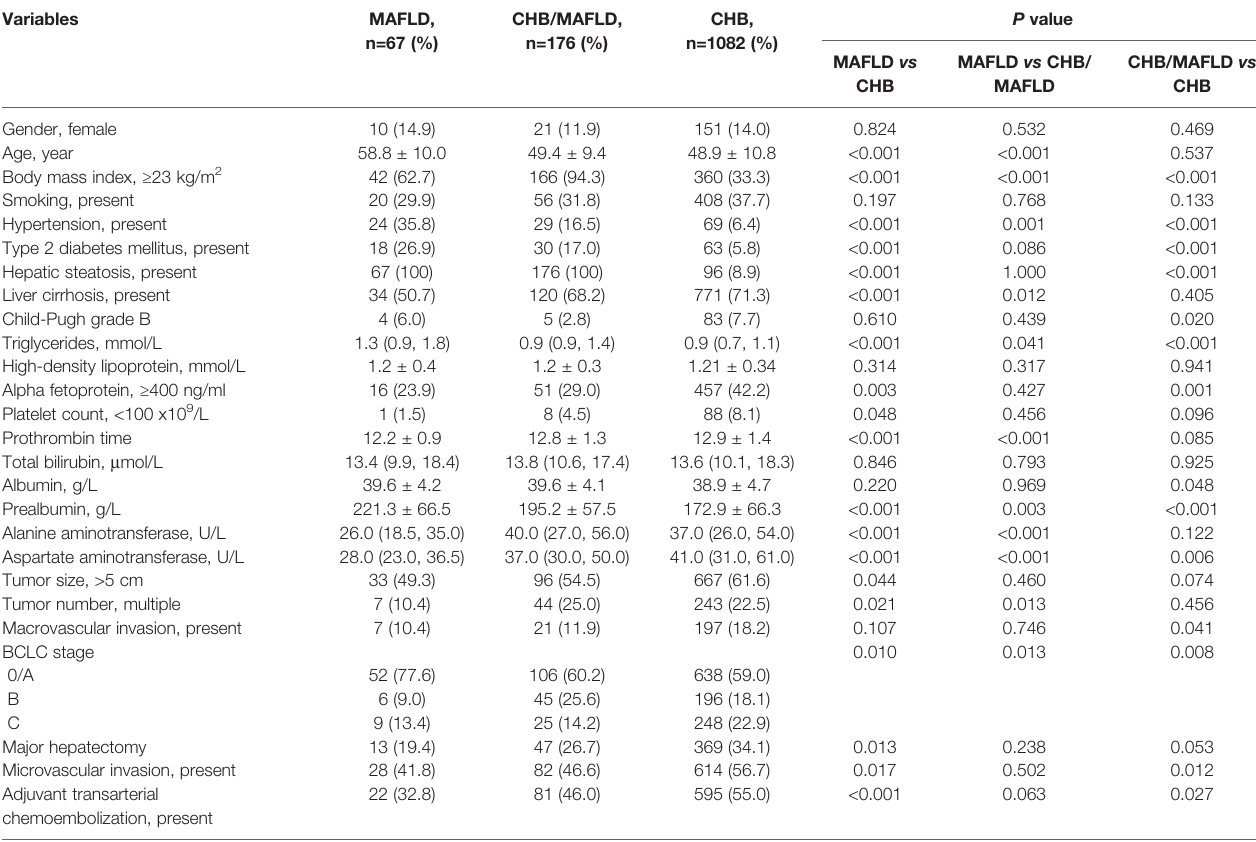
TABLE 1 | Patient baseline demographic and clinical characteristics.